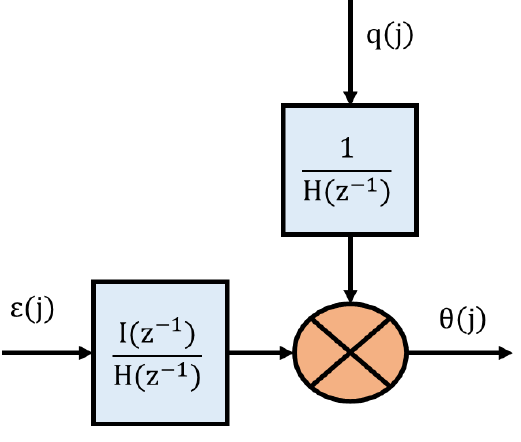
Figure 1. ARX model block diagram.